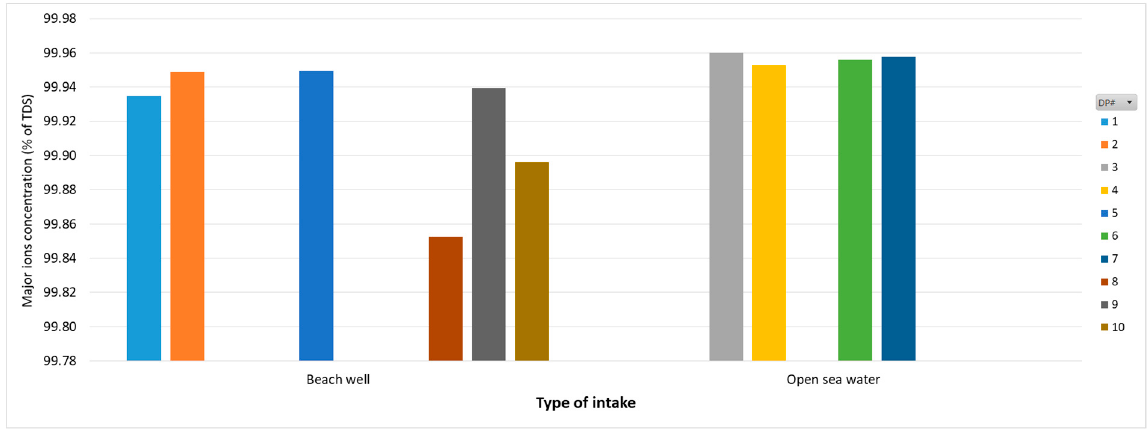
Figure 4. Sum of major ions in brine (as a percentage of TDS) per DP# by type of intake. Percentage of silica (SiO 2 ) related to TDS. Notable di ff erences were found between open sea water intakes, where there is no trace of silica (<2.41 mg/L), and beach well in- takes, where the percentage of SiO 2 related to TDS can be around 0.02–0.13%, with abso- lute values of 15–80 mg/L. These high values can be a tt ributed to the volcanic nature of the Canary Islands [59].